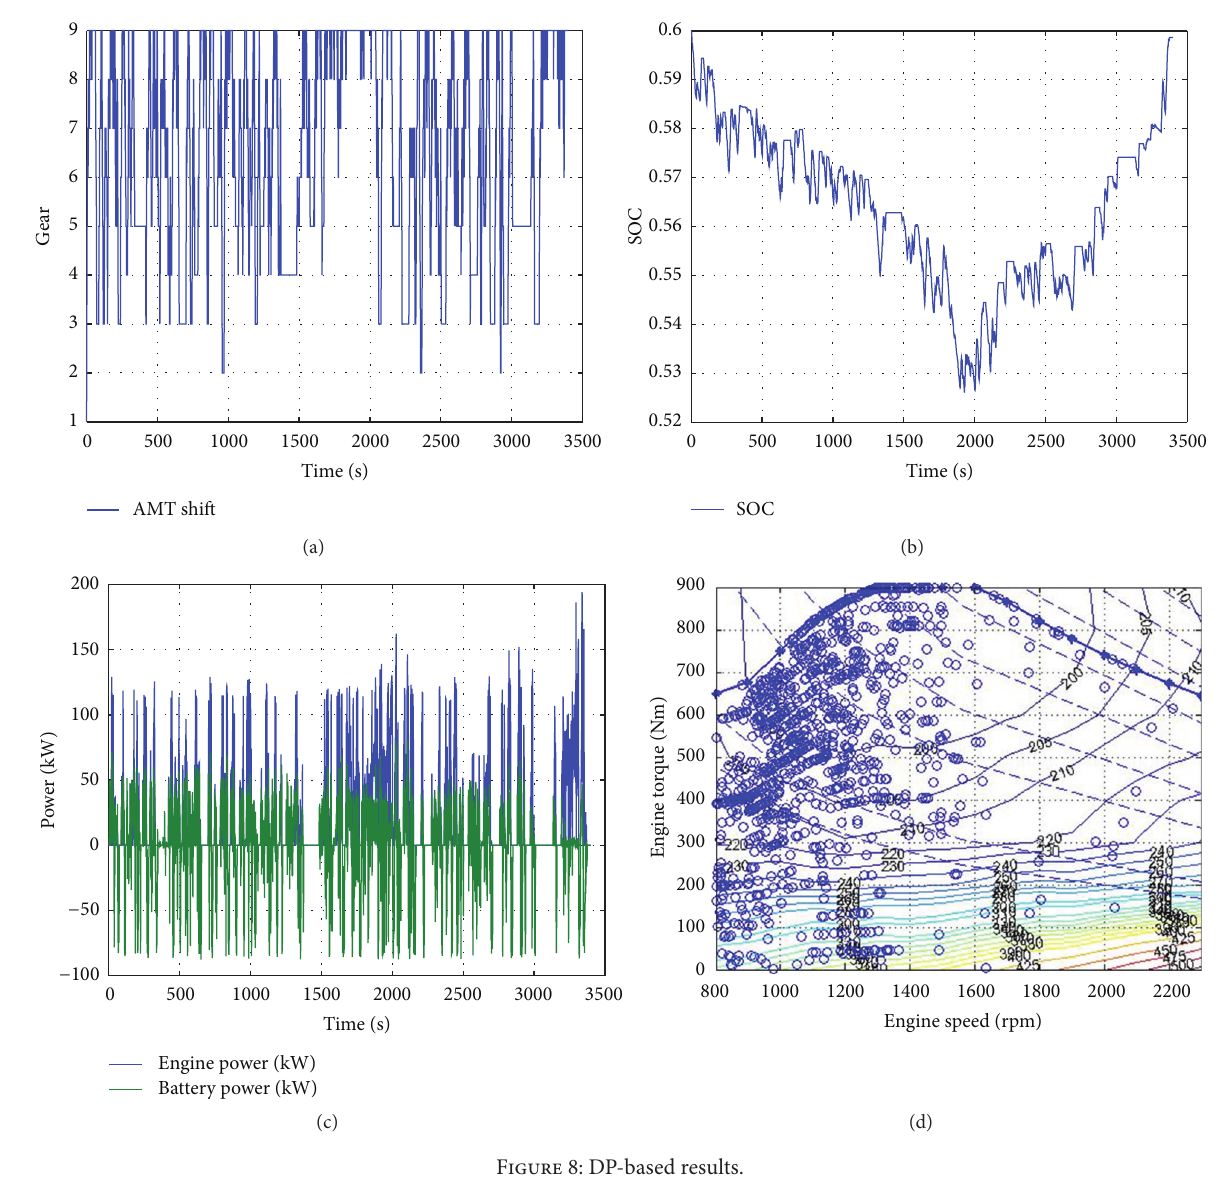
Figure 8: DP-based